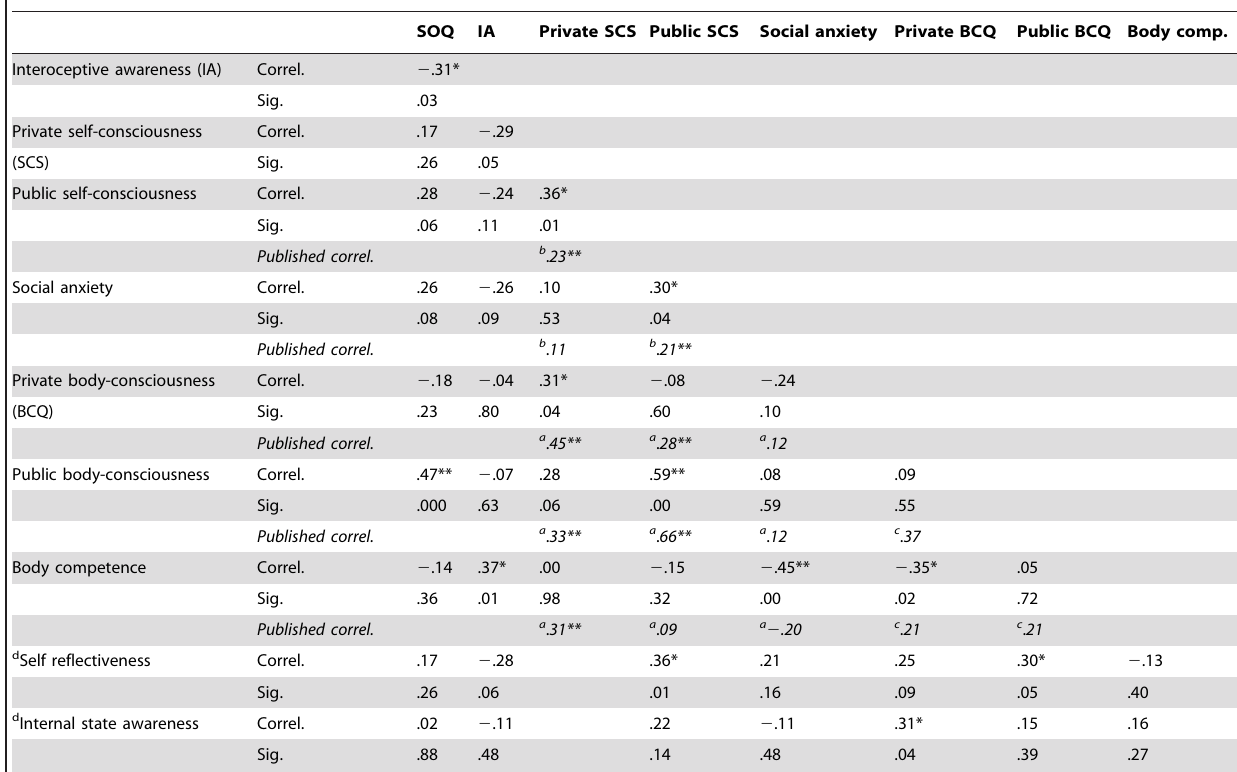
Table 2. Correlations between the measures.